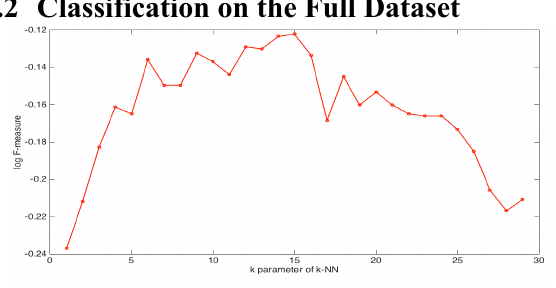
Figure 3: Plot of log F-Measure (y-axis) against